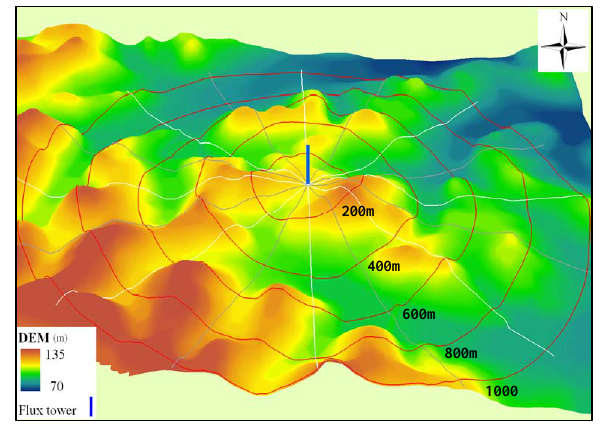
Fig. 1. Area relief map of the Qianyanzhou site based on Digital Elevation Model (DEM). The tower is located in the middle of the map, with 200m equidistance